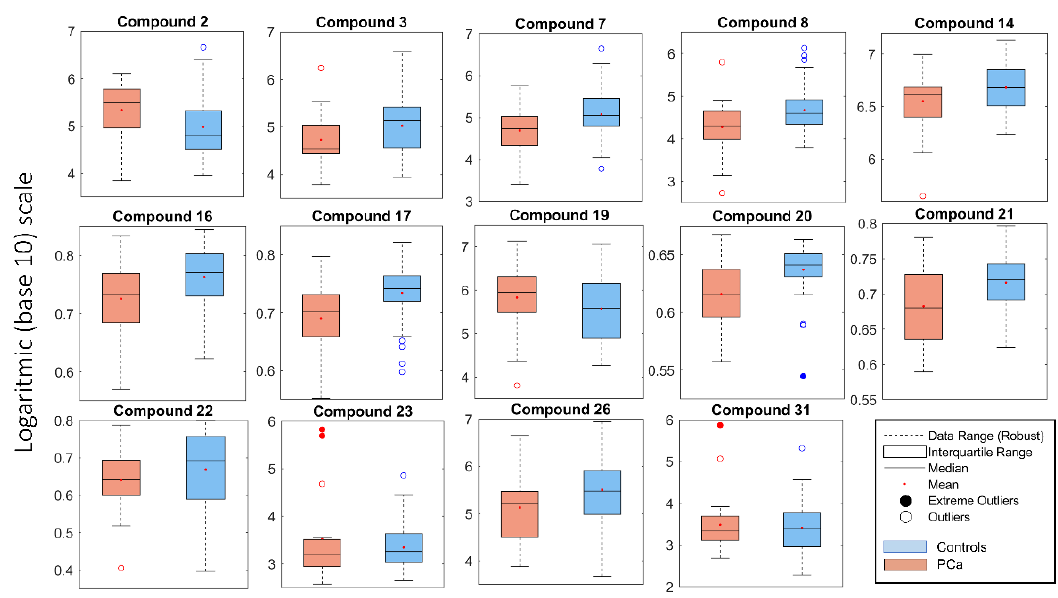
Figure 4. Boxplot, in logarithmic (base-10) scale, of the 14 compounds above the selectivity ratio threshold of 0.07 (see Figure 3).